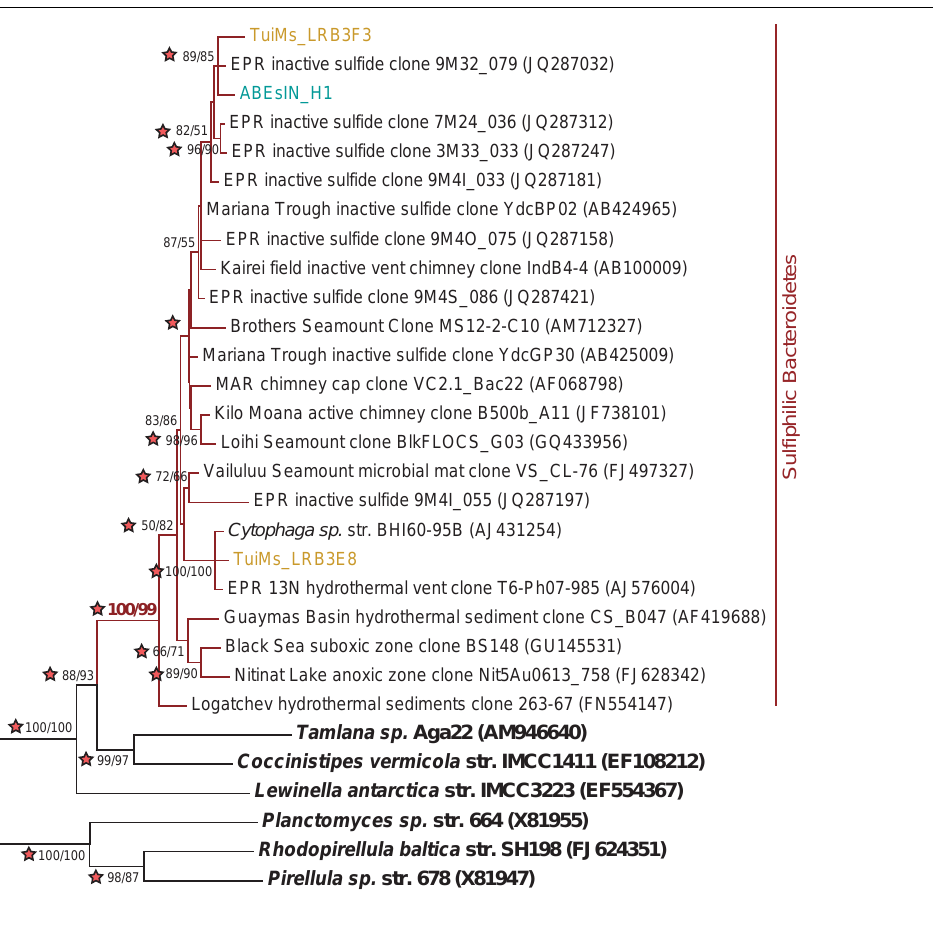
FIGURE 9 | Phylogenetic tree of representative clones from this study that fall within the Sulfiphilic Bacteroidetes clade (red branches). One representative clone was chosen from each study and from each sample if multiple samples are represented from a study.The tree was generated in MEGA 5 (Tamura et al., 2011) using the maximum likelihood method with the Jukes–Cantor model, Gamma distribution and 1000 bootstrap replicates.The